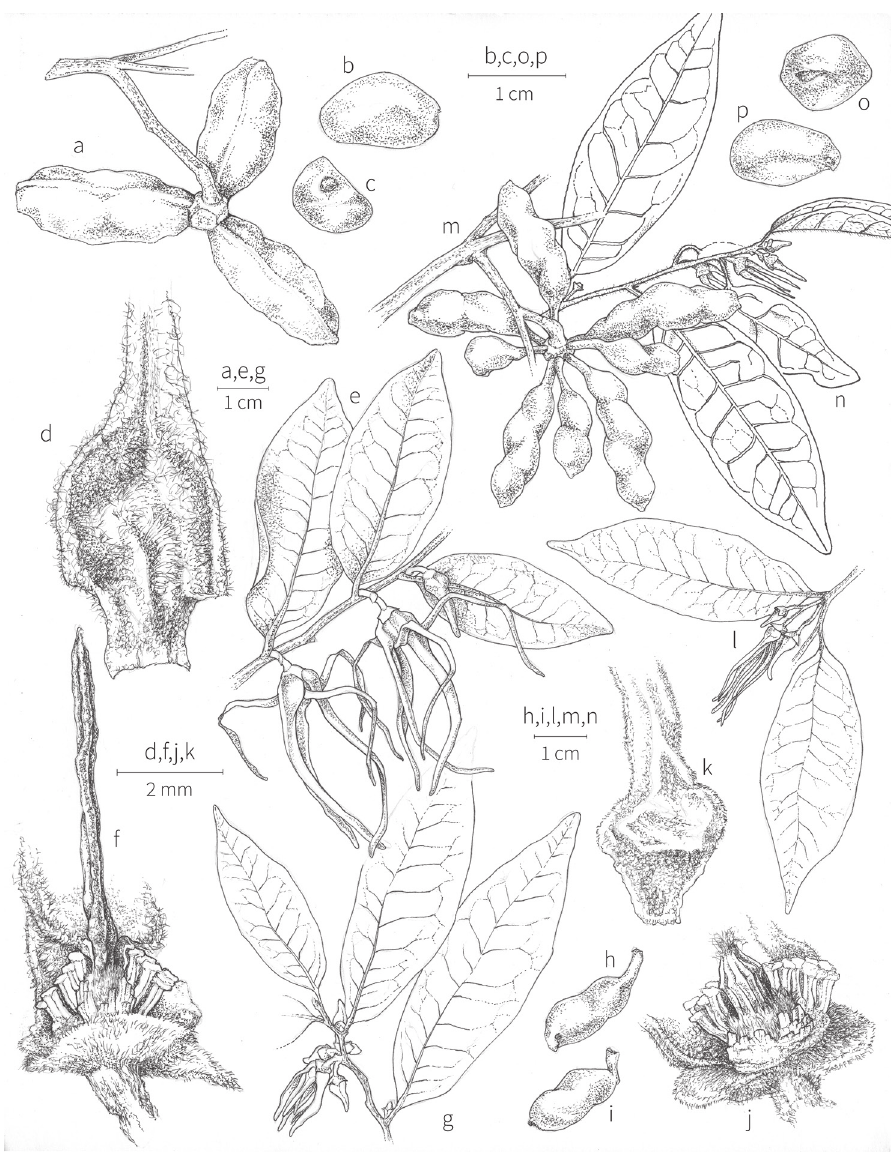
Figure 27. Xylopia longipetala , X. holtzii , X. katangensis , and X. shirensis . A–F X. longipetala A Fruit B Seed, side view C Seed, view of micropylar end D Base of inner petal, adaxial view E Habit F Gynoe- cium surrounded by staminal cone with a few attached stamens G–K X. holtzii G Habit H, I Detached monocarps J Gynoecium surrounded by staminal cone with a few attached stamens K Base of inner petal, inner (adaxial) surface L X. katangensis , habit M–P X. shirensis M Fruit N Habit O Seed, view of micropy- lar end P Seed, side view. A–C from Jongkind & Nieuwenhuis 3031 (WAG) D, F from McPherson 17911 (MO) E from Hallé & Le Thomas 190 ( P ), and following photograph of fresh flowers of same collection in Le Thomas (1969) G, J, K from Johnson et al. 1938 (OWU) H, I from Templer H167/53 (K), L from Letouzey 4498 (MO) M from Richards 13266 (K) N from Richards 14438 (K) O, P from Bredo 6276